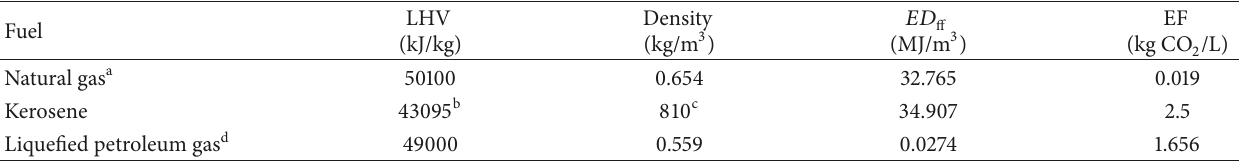
Table 1: Properties of fossil fuels used for